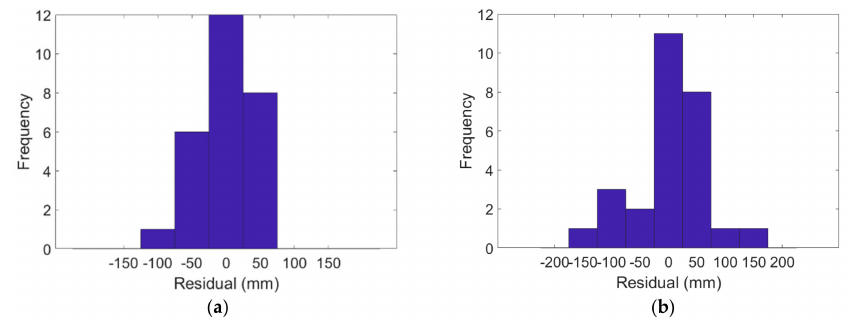
Figure 12. Histogram of the frequency distribution. ( a ) Convex shape and ( b ) saddle shape.